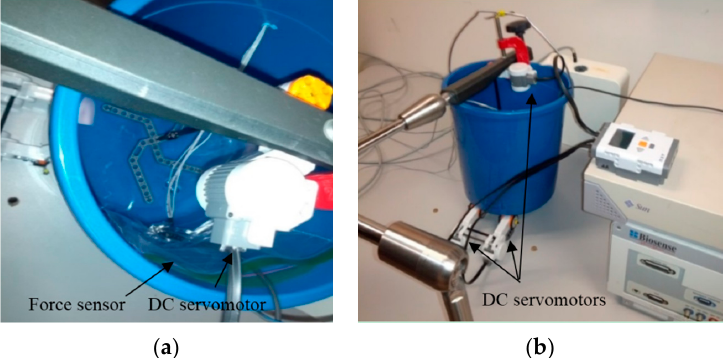
Figure 13. Experimental apparatus mimicking an intra-cardiac chamber for CFSE: ( a ) Close-up view of the setup consisting of EM tracking system, a motor for fluid circulation, ablation catheter and the force sensor; ( b ) Two dc servomotors translating the aforementioned assembly for making the dynamic interacting load.